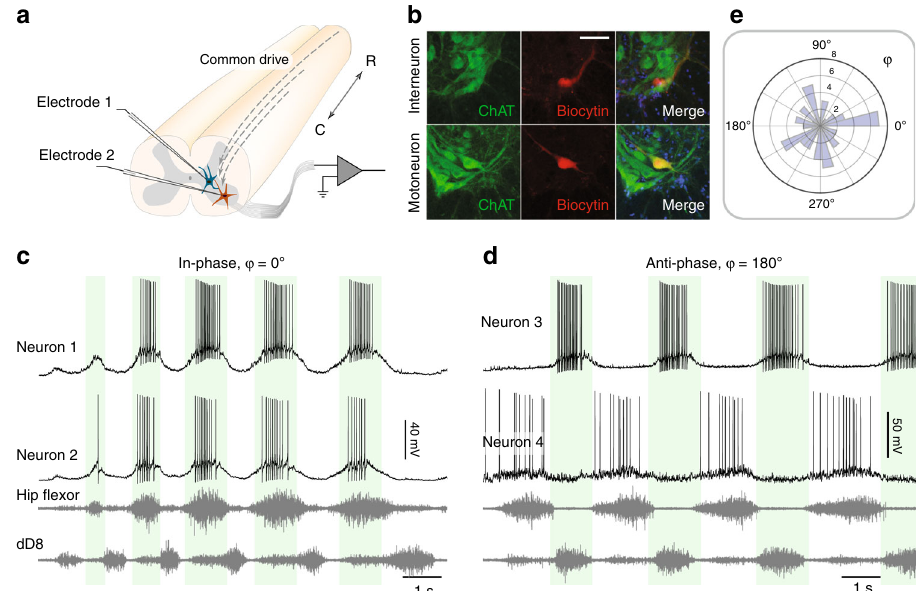
Fig. 3 Diverse phase relations during spinal motor patterns. a Experimental setup: Pairwise intracellular recording from the lumbar spinal cord of turtles (medial – ventral horn) during touch – induced scratching. b Histology of a recorded pair of neurons fi lled with biocytin (red) reveals an IN (Choline Acetyl Transferase (ChAT) – negative, top row) or a MN (ChAT – positive neuron, green, bottom row). Scale bar 50 μ m . c Two in – phase neurons during motor activity concurrent with hip – fl exor and a knee – extensor synergist (dD8) nerve activity. d Anti – phase MN – IN neuron pair (histology shown in from b ). Shaded regions indicate on – phase of the top panel neuron. ( e ) Phase between pairs indicates wide representation from 0 to 360° ( n = 66 pairs). ChAT choline